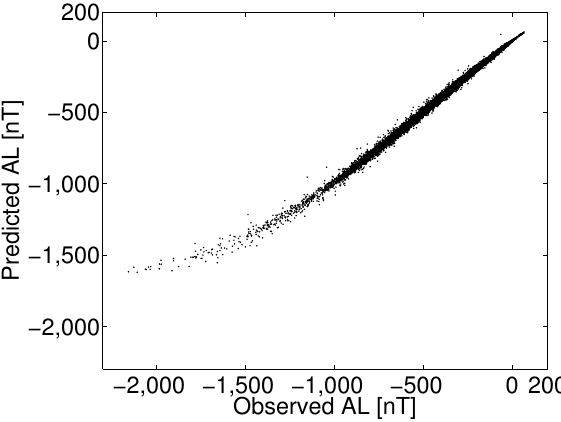
Fig. 3. Observed AL vs. predicted AL, using data from validation testbed (January–May